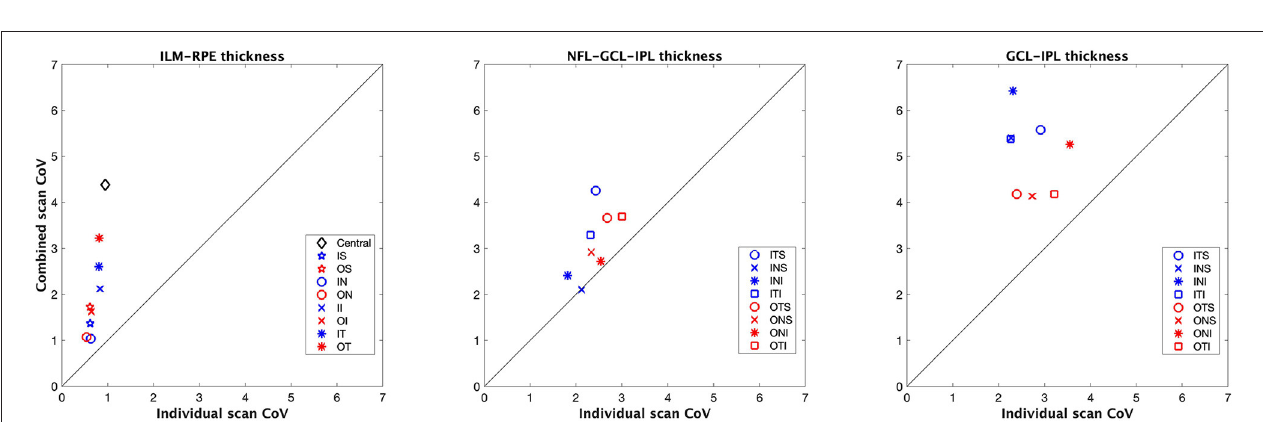
Figure 1 legend for sector abbreviations.